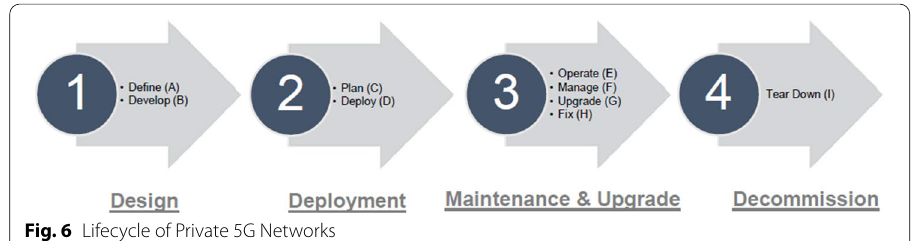
Fig. 6 Lifecycle of Private 5G